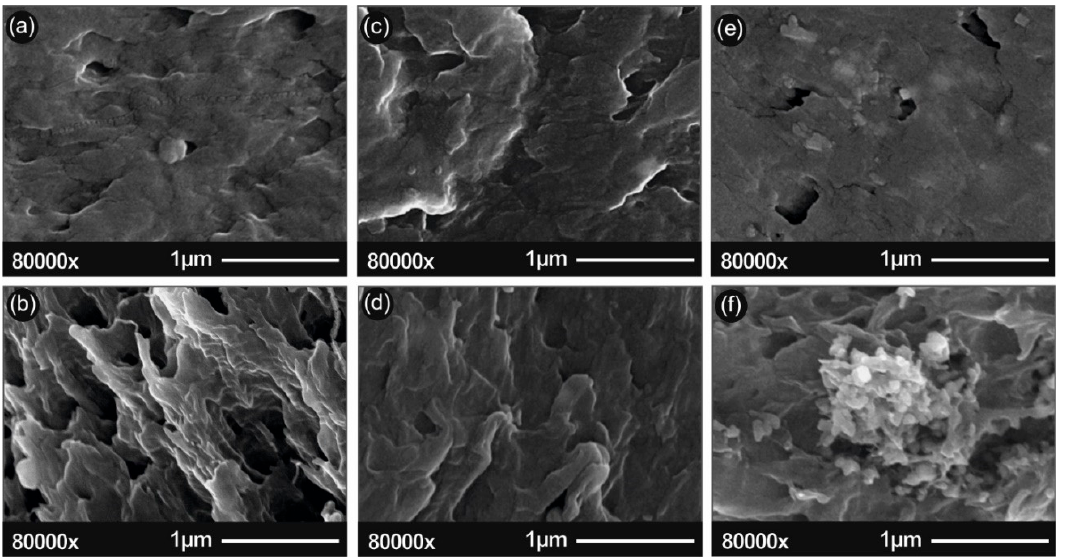
Figure 3. ( a ) Scanning electron microscopy (SEM) images of pure ABS surface area; ( b ) pure ABS